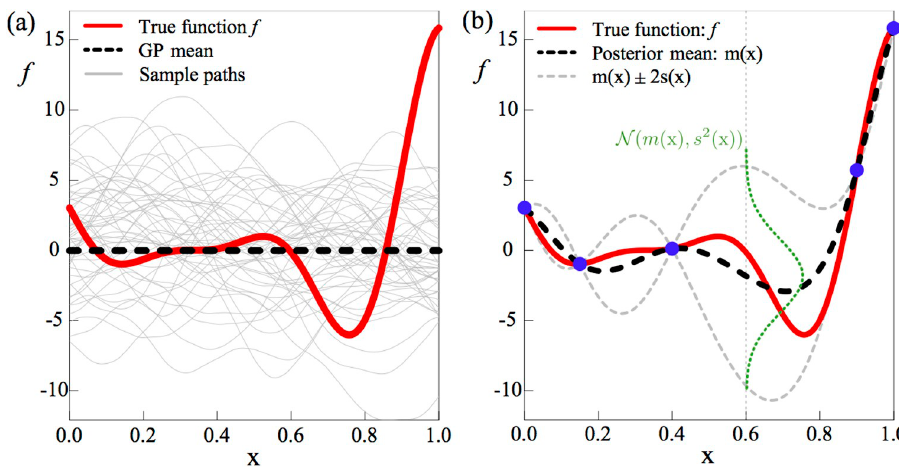
Fig 1. GP is a probability distribution over functions. The thick solid red line is the true function f and the thick dashed black line is the GP “prior”. (a) Thin grey lines show sample functions of the GP. (b) Blue bullets indicate five data points sampled from f . The GP distribution is updated using these sample data points. The thin grey dashed lines show m (x) ± 2 s (x).